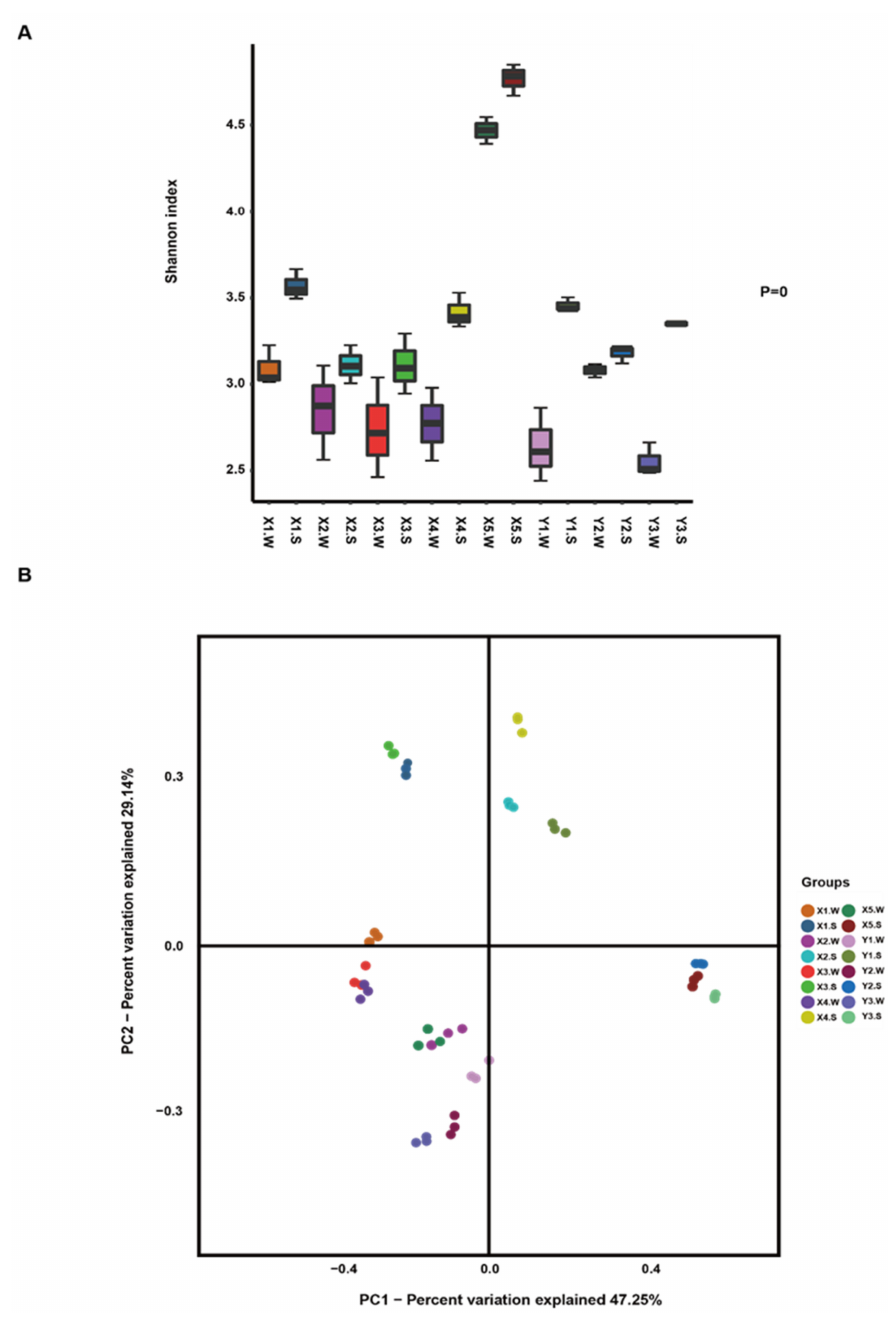
Figure 3. Alpha and beta diversity in all 48 samples. ( A ) Boxplots of the Shannon index values of the eight sites, where S indicates a sediment sample and W indicates a water sample. ( B ) First two axes of weighted UniFrac principal coordinate analysis (PCoA) at the OTU level of beta diversity analysis. Each group color coding is the same as for panel